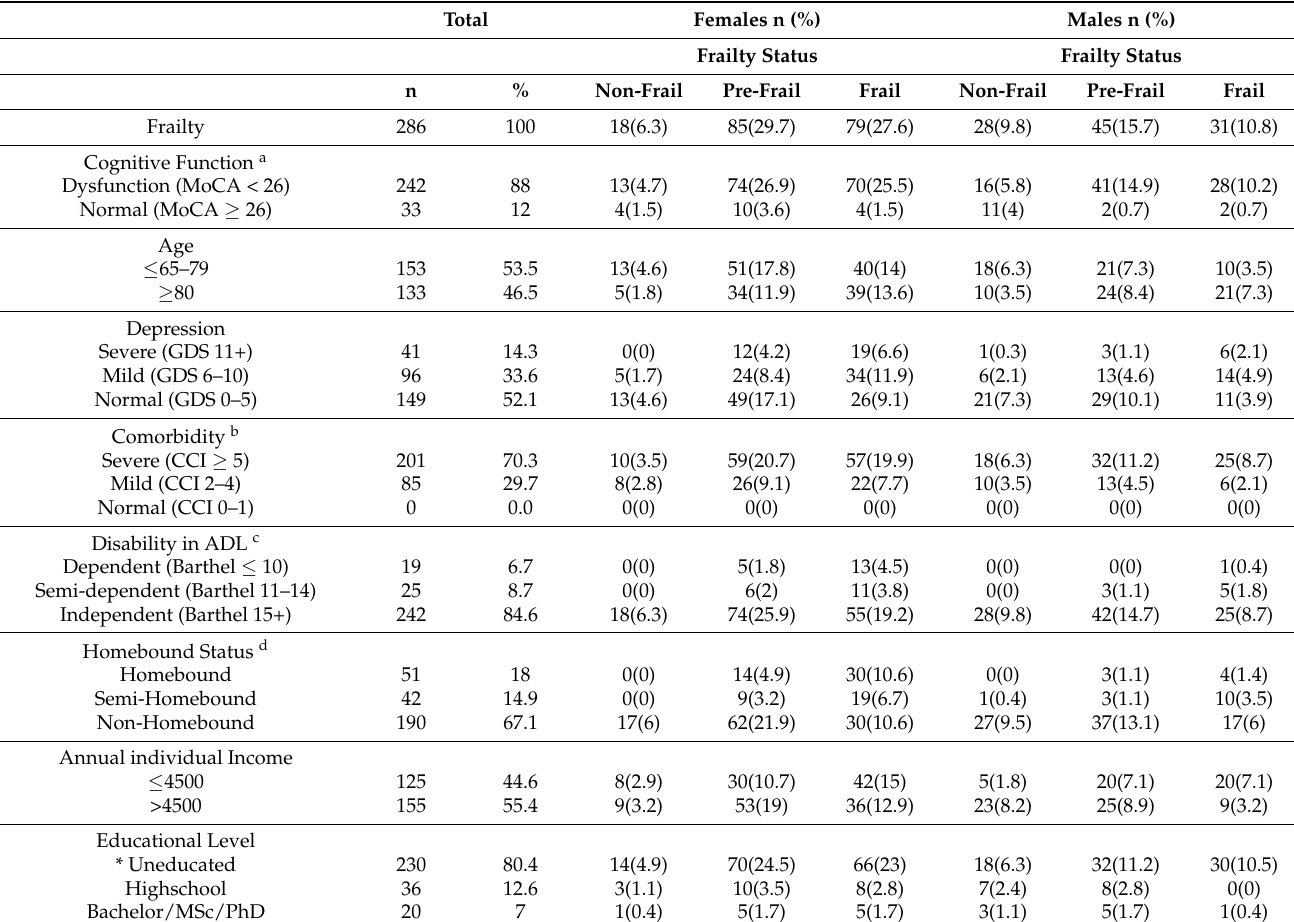
Table 2. Frequency of the socioeconomic factors with respect to frailty status (n =